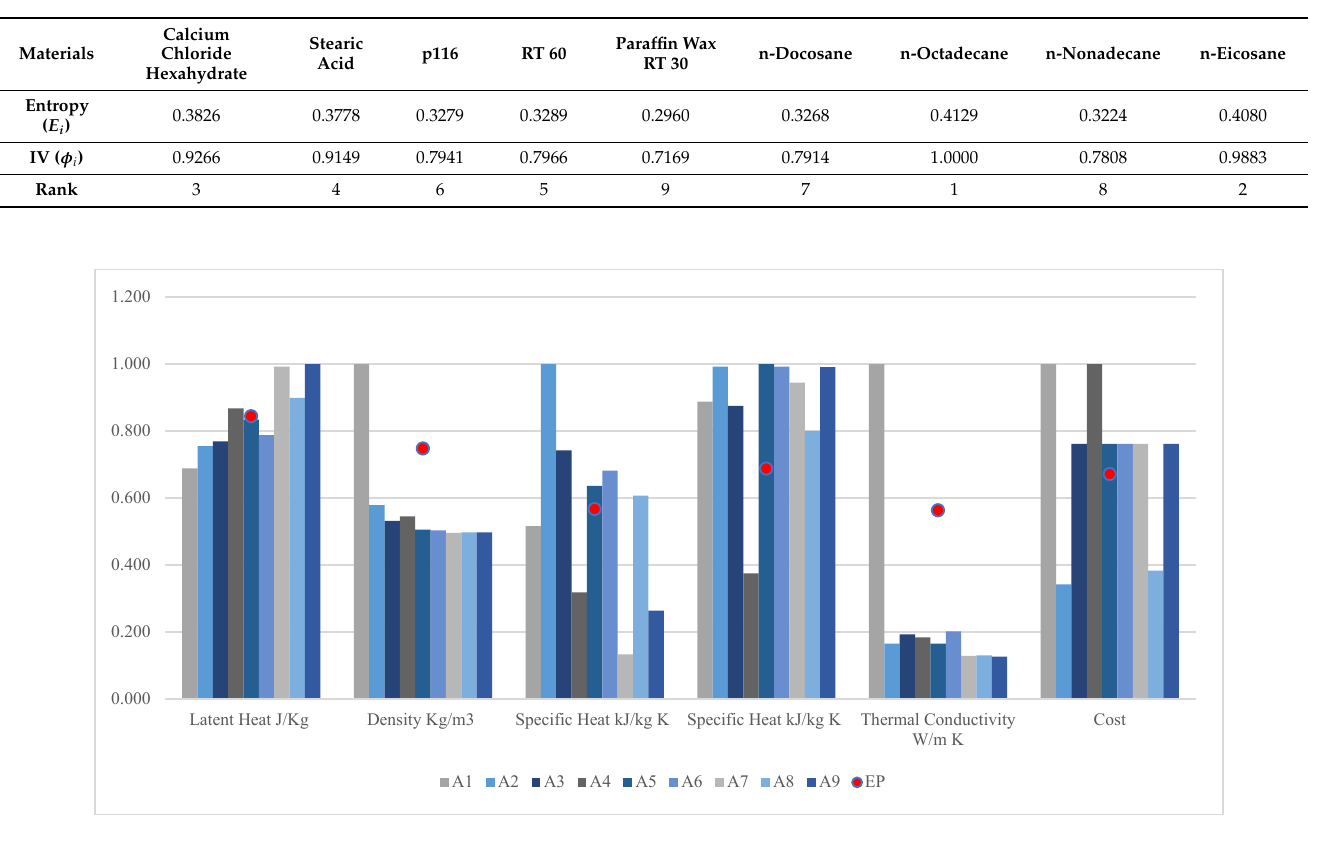
Information 2022 , 13 , 512 Figure 2. The EP compared with the alternatives’ data sets. Figure 2. The EP compared with the alternatives’ data sets.